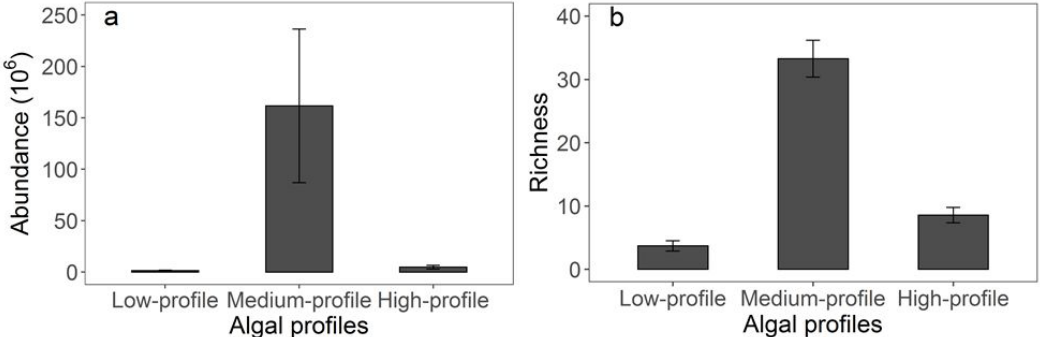
Figure 6. Mean and standard error of the abundance (a) and richness (b) of periphytic algal profiles from the control aquarium. Table 3. Results from generalized linear mixed model fit with binomial negative estimation of the richness of peri- phytic algal profiles (low, medium and high) from the food content of Moenkhausia sanctaefilomenae between treat- ments T1 (without zooplankton) and T2 (with zooplankton). The intercept represents the levels “Treatment-T1” and